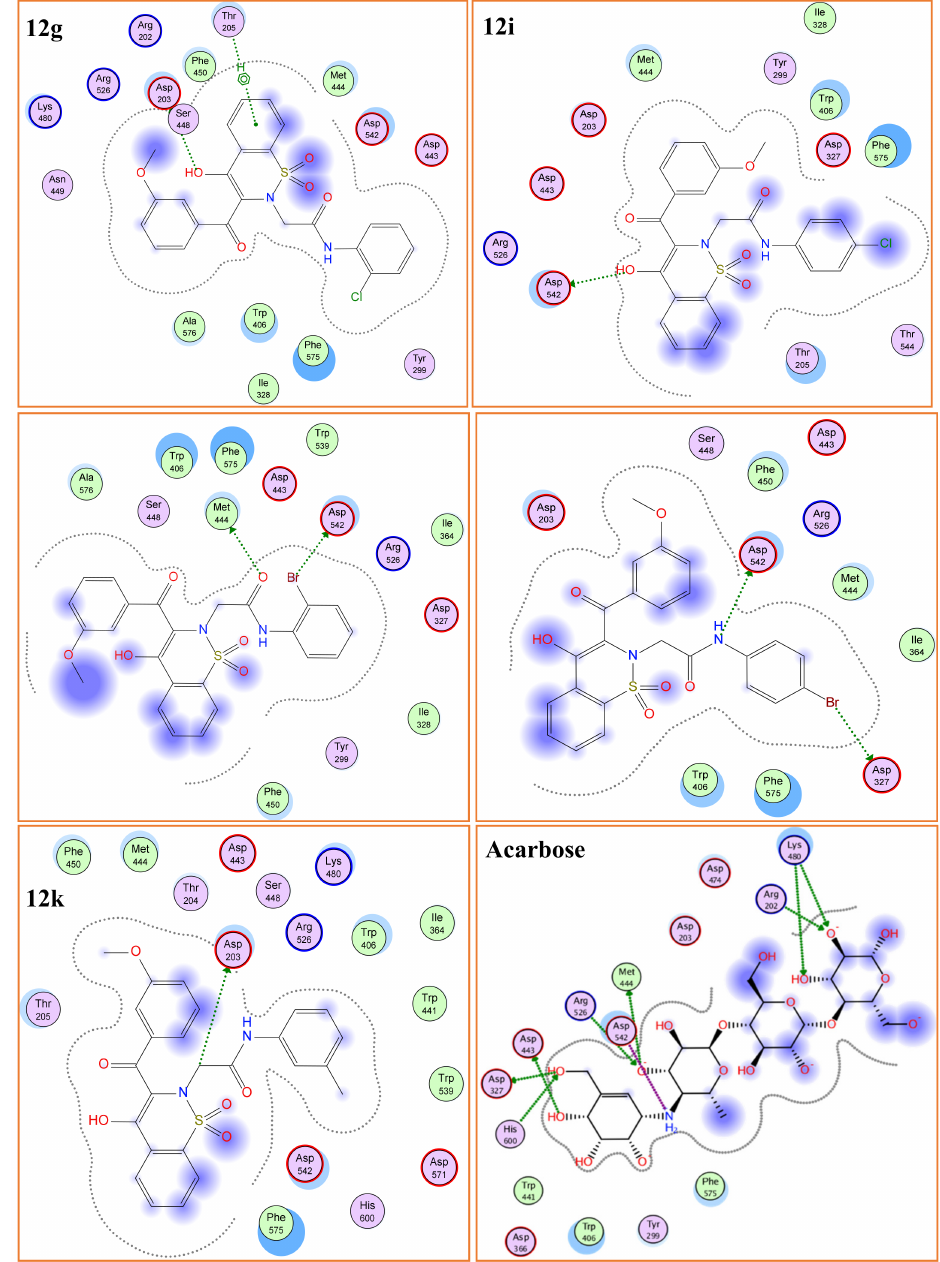
Figure 2. Binding interactions (2D maps) of potent compounds ( 12a , 12c , 12g , 12i , 12k ) and the reference drug, acarbose, against α -glucosidase enzyme. Ligand exposure points are indicated with blue color, while the binding interactions of ligands with the receptor enzyme are indicated with green dotted